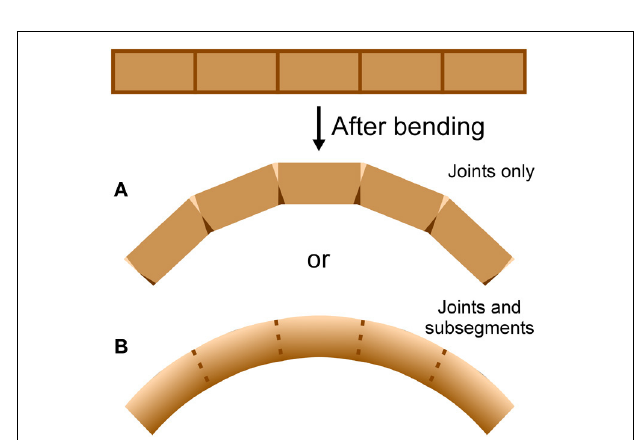
FIGURE 3 | Bending location. A cylindrical structure with apparent joints could actually bend at (A) the joints only or (B) the joints and the flagellomeres, depending on the mechanical behavior of the joints and the flagellomeres. Darker areas indicate shortening (such as by cuticle folding or compressing) and lighter areas indicate lengthening (such as by cuticle unfolding or